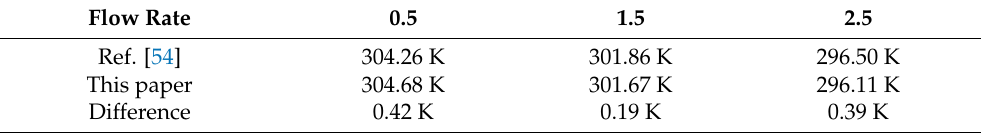
Table 5. Outlet temperature values of water at different flow rates in a solar collector at different hours: a comparison between the present work and the experimental data of Aghakhani et al. [54]. Flow